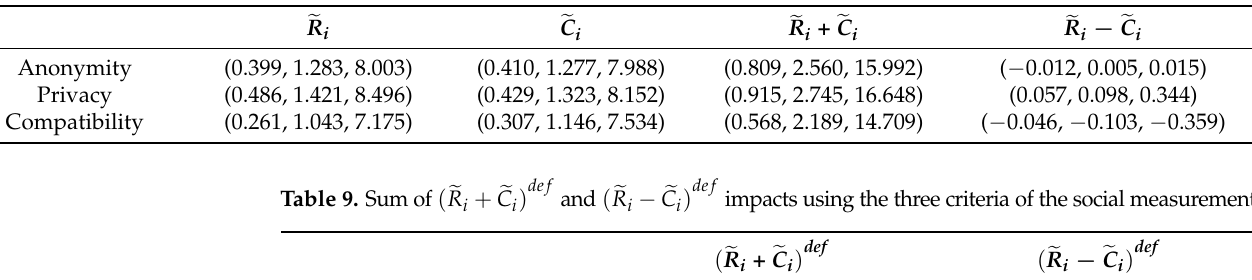
Figure 5. Graph of appearing causal relationships between the second-tier criteria of the social measurement. Table 8. Sum of (cid:101) R i , (cid:101) C i , (cid:101) R i + (cid:101) C i , and (cid:101) R i − (cid:101) C i impacts using the second-tier criteria of the social measurement.